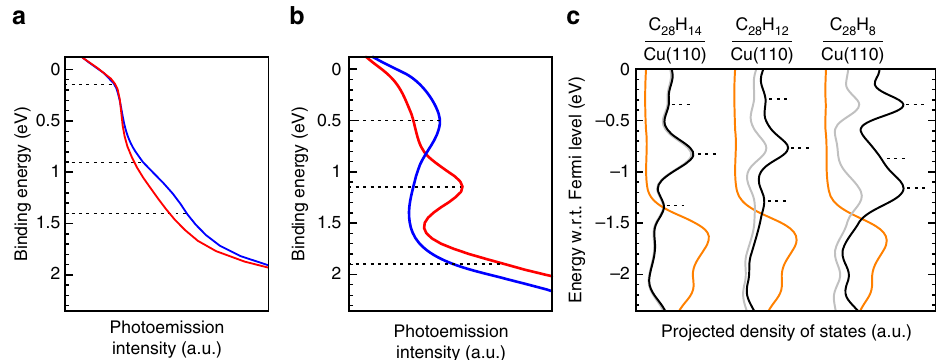
Fig. 2 Valence band of DBBA on Cu(110) before and after annealing at 250°C. a Energy distribution curves (EDCs) of as-deposited DBBA measured along [001] (blue curve) and [ (cid:1) 110] (red curve) directions of Cu(110). b EDCs after annealing of DBBA at 250 °C measured along [001] direction of Cu(110) (blue curve) and 25° away from [ (cid:1) 110] direction (red curve). For the EDCs, the photoelectron intensity was integrated over the polar angle range of 0° to + 85°. c DFT calculations of density of states (DOS) of C 28 H 14 , C 28 H 12 and C 28 H 8 on Cu(110). The orange lines show the total DOS, while the black and grey lines display the DOS projected onto the molecule and the π -states of the molecule, respectively. The dotted lines mark energies corresponding to experimental and theoretical k -maps in Figs. 3 and 4